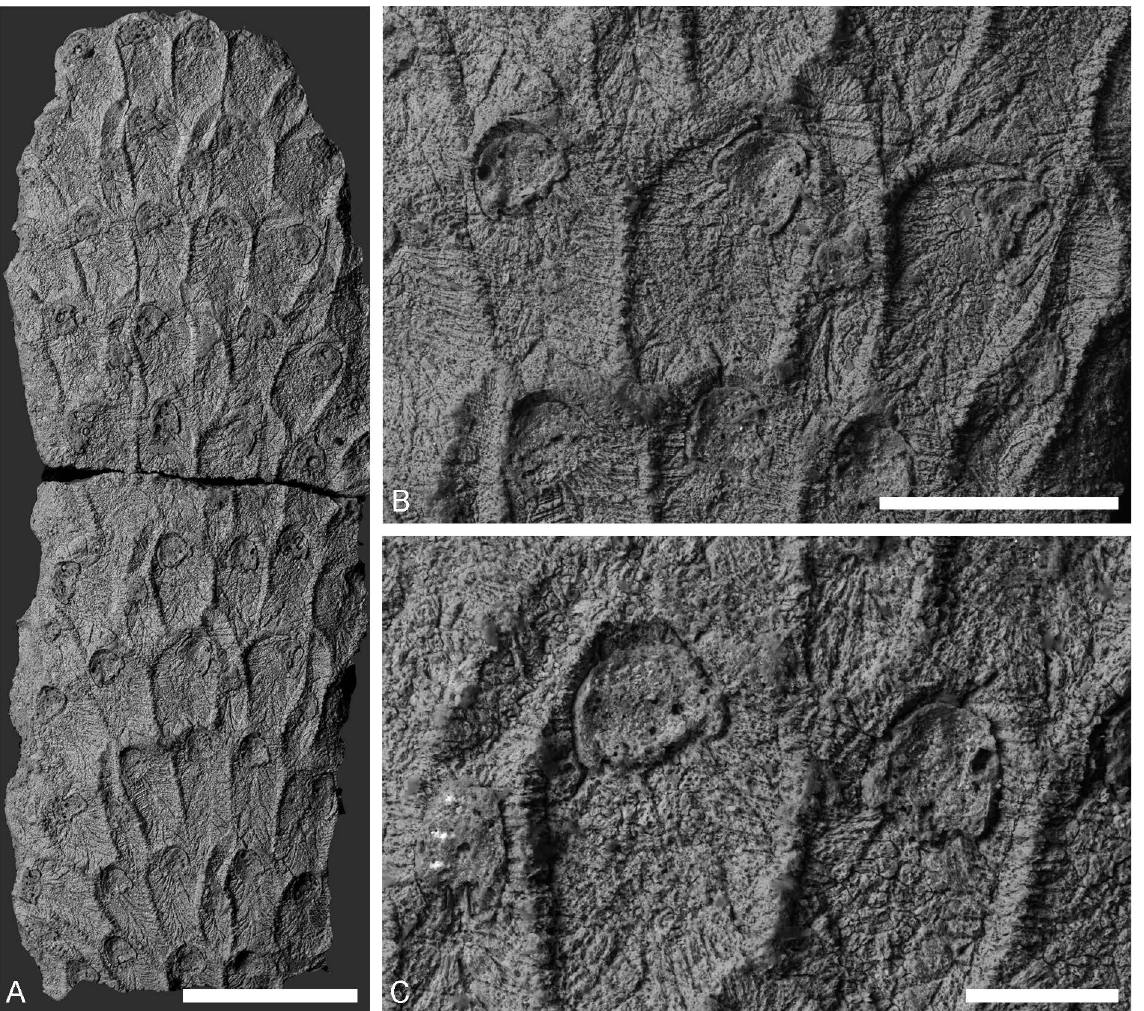
Fig. 11. Rhagasostoma operculatum sp. nov. A–C . Holotype, TsNIGR Museum 27/12582, western Kopetdag, Turkmenistan, boundary between the early and late Campanian ( Cibicidoides temirensis / Bolivinoides decoratus decoratus Zone, LS13). A . Overview of erect bifoliate colony. B . Autozooids with putative opercula and avicularia. C . Autozooids with putative opercula and avicularium. Scale bars: A = 1 mm; B = 500 µm; C = 200